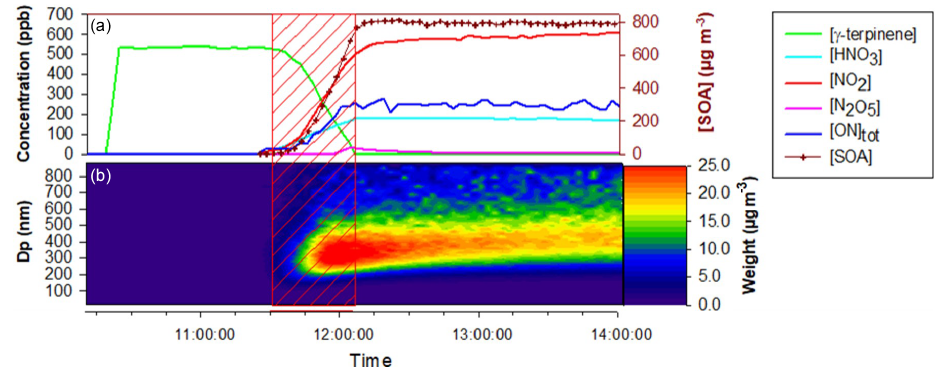
Figure 4. Time-dependent concentration of gaseous species, aerosol mass (corrected from dilution), SOA size distribution and PTR-ToF- MS signals during a typical experiment of NO 3 -initiated oxidation of γ -terpinene (25 April 2017). Red hatched area corresponds to N 2 O 5 injection period. (a) γ -terpinene, N 2 O 5 , NO 2 , HNO 3 and total ONs from FTIR spectroscopy and SOA mass concentration from SMPS; b SOA size distribution in mass concentration from SMPS.